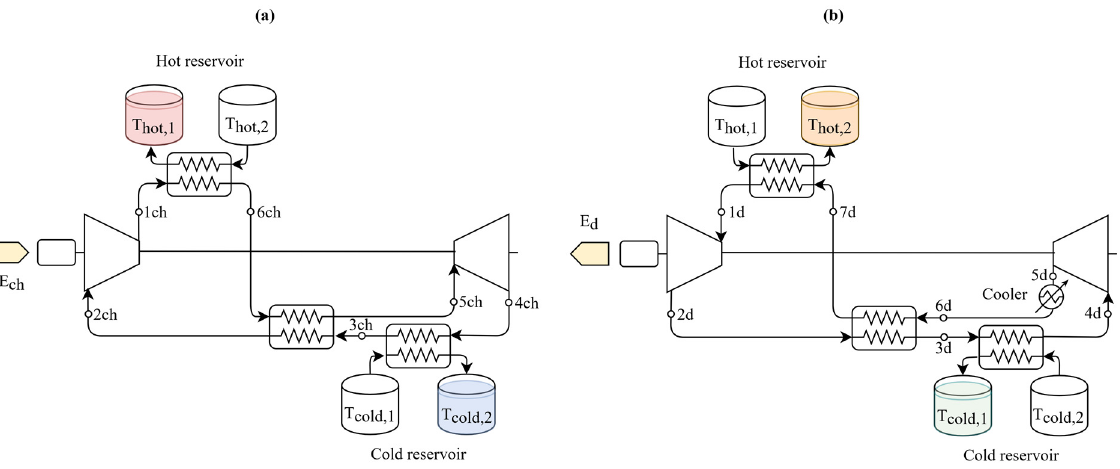
Figure 1. Brayton PTES system with liquid-based thermal exergy storage (LBPTES): ( a ) charge system; ( b ) discharge system.